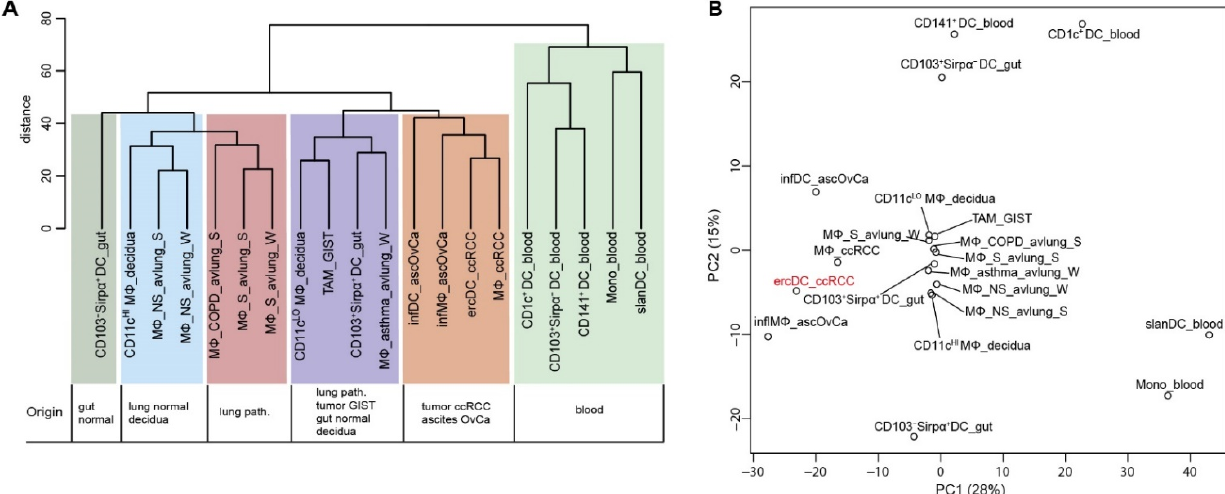
Figure 3. Transcriptome relationship of ercDC_ccRCC and myeloid cell types from blood and non- lymphoid healthy and pathological tissues. ( A ) Hierarchical clustering of indicated cell types based on median expression values of replicate samples considering only the top 50% of genes with highest variation across cell types (6107 “informative” genes). ( B ) PCA on same data set as described in ( A ). Shown are the first two PC that describe 28% and 15% of the variance, respectively. To assess if expression states of specific genes can distinguish ercDC_ccRCC from other myeloid subtypes, we used the nearest shrunken centroids method (NSCM) [34], a